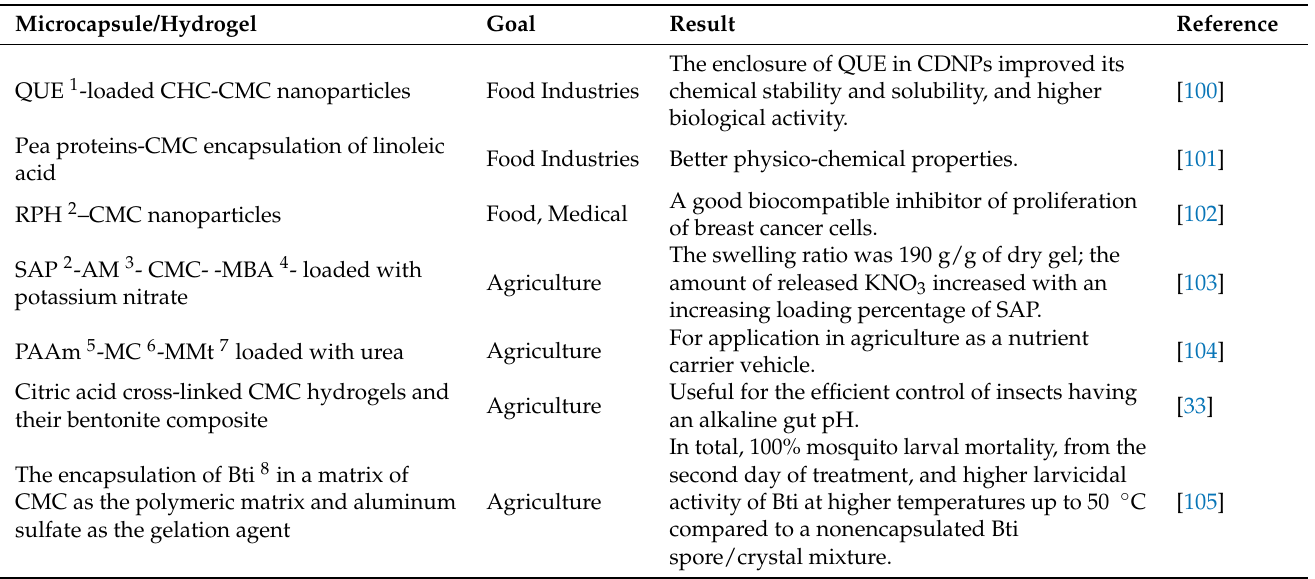
Table 4. Application of CMC for encapsulation of bioactive